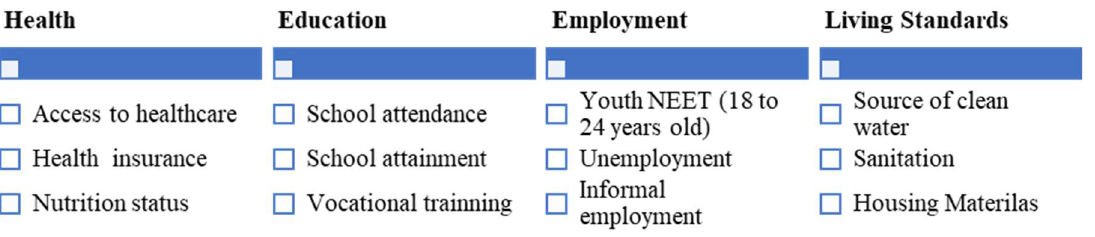
Figure 1. Example of the Multidimensional Poverty Measure. Source: Author’s own